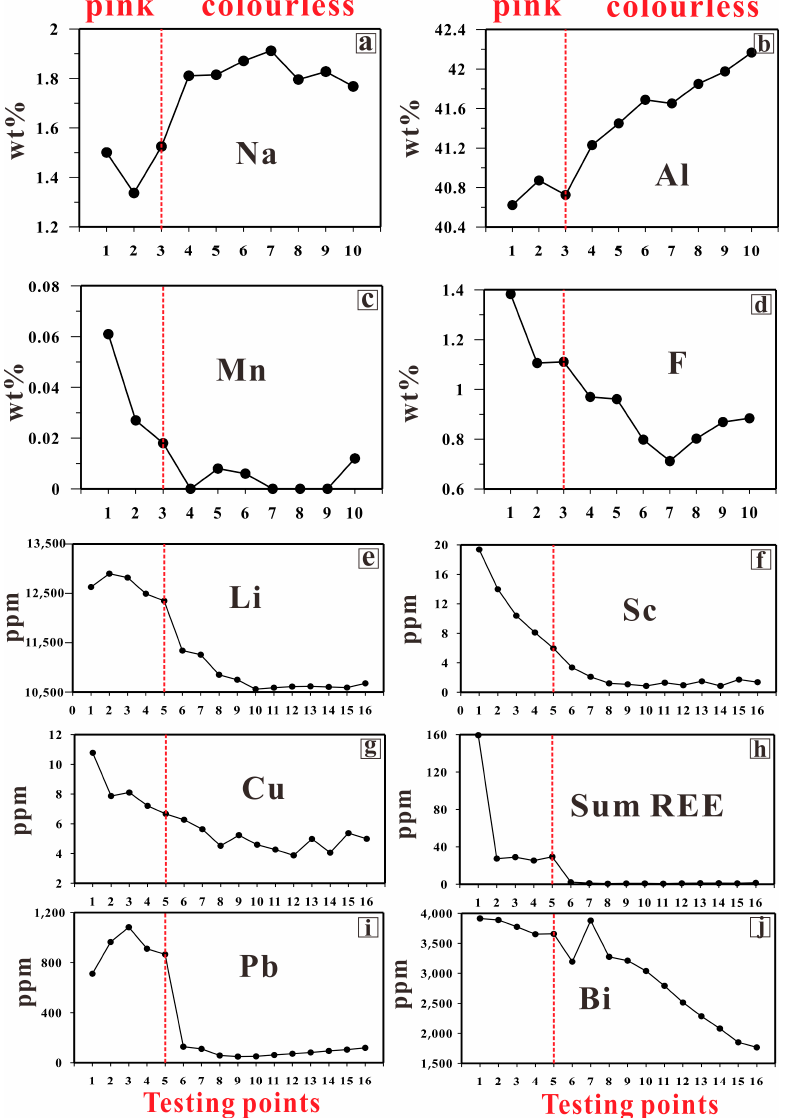
Figure 7. ( a – d ) show the major elements Na, Al, Mn, F (wt%), and ( e – j ) show trace element (ppm) concentrations from pink to colourless parts in